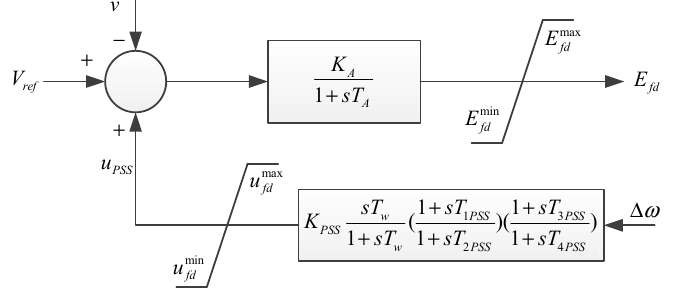
Figure 1. A simple automatic voltage regulator (AVR) with fixed-structure lead-lag type power system stabilizer (PSS).